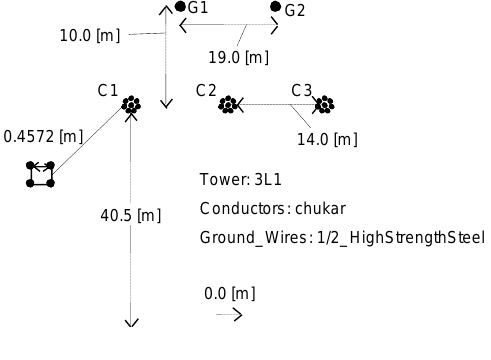
Figure 11. The tower model.